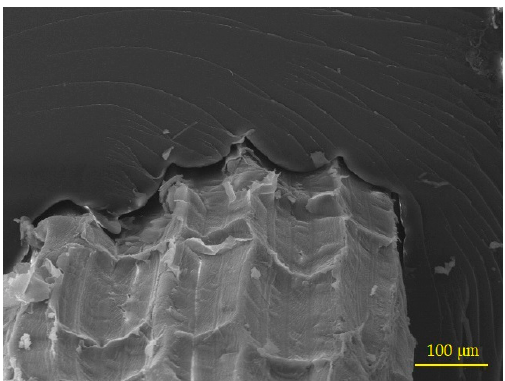
× , bas corresponds to 100 µ